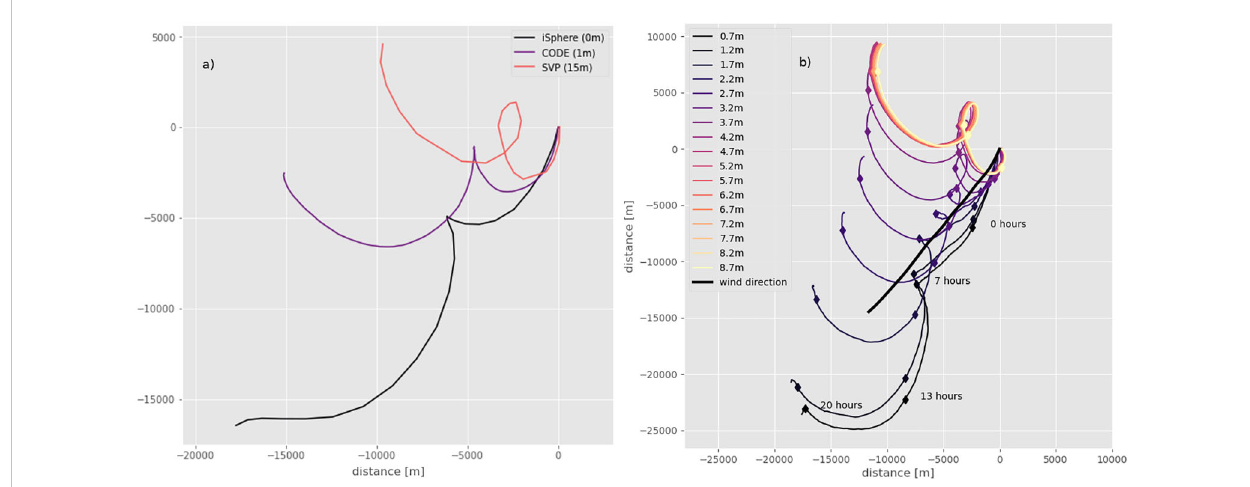
FIGURE 1 (A) Trajectories from GPS-tracked drifters at three different depths. (B) Progessive vector diagram of ADCP current velocities at various depths during the same time period as in (A)